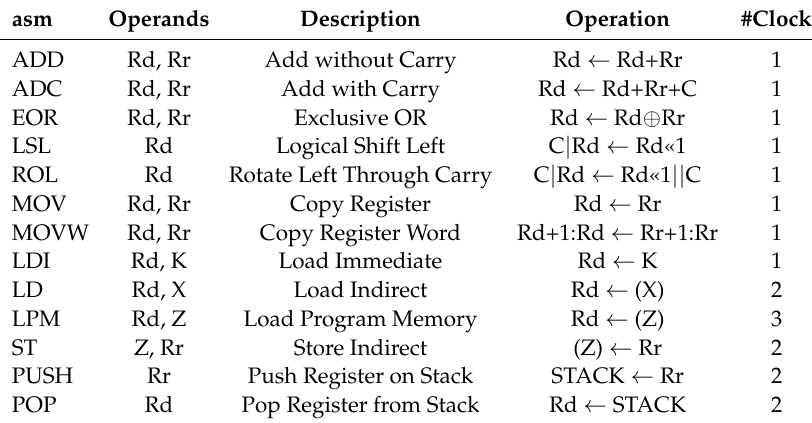
Table 1. Summary of instruction set for optimized CHAM implementations on 8-bit Addition, Rotation, and eXclusive (ARX) microcontrollers